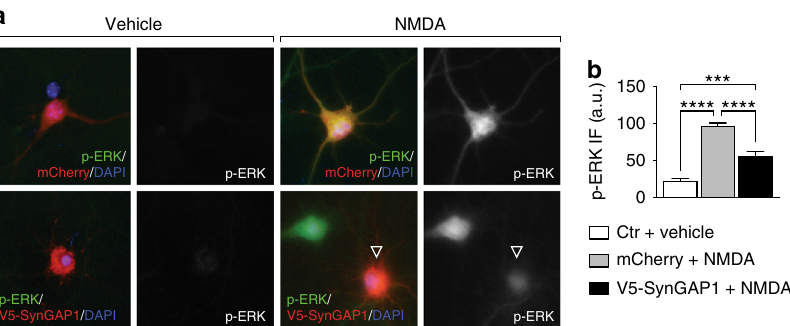
Fig. 8 Expression of SynGAP1 mitigated NMDA-induced ERK activation in primary neurons. a Primary neurons transiently over-expressing V5-SynGAP1 ( red ) showed less ERK phosphorylation (p-ERK, green ) in response to NMDA exposure, compared to control cells expressing mCherry ( red ) (or untransfected cells). No p-ERK was detected prior to NMDA treatments. b Quanti fi cation of fl uorescence intensity of p-ERK signals in transfected neurons showed a signi fi cant reduction of ERK activation after NMDA in V5-SynGAP1 − compared to mCherry-expressing neurons. Controls (ctr) comprised both mCherry, SynGAP1 or untransfected cells (*** p < 0.001; **** p < 0.0001; N = 3; one-way ANOVA (Tukey post hoc)). All error bars are